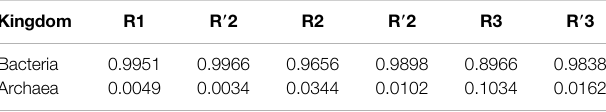
TABLE 5 | Relative abundances of bacteria and archaea present during different AD stages at kingdom level.